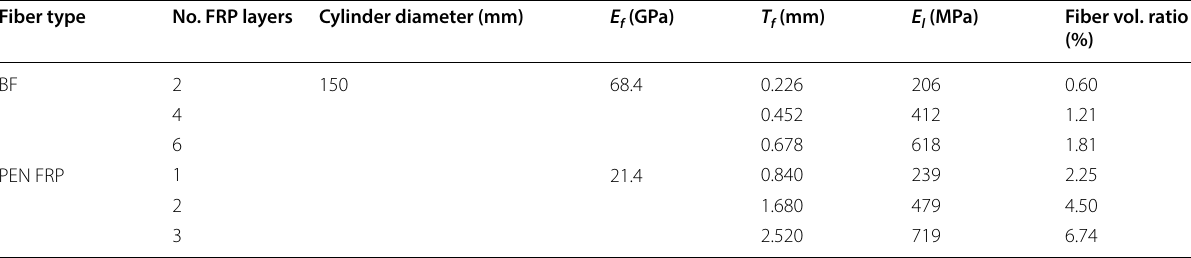
Fiber vol. ratio vol. of fibers/vol. of concrete per unit length. =